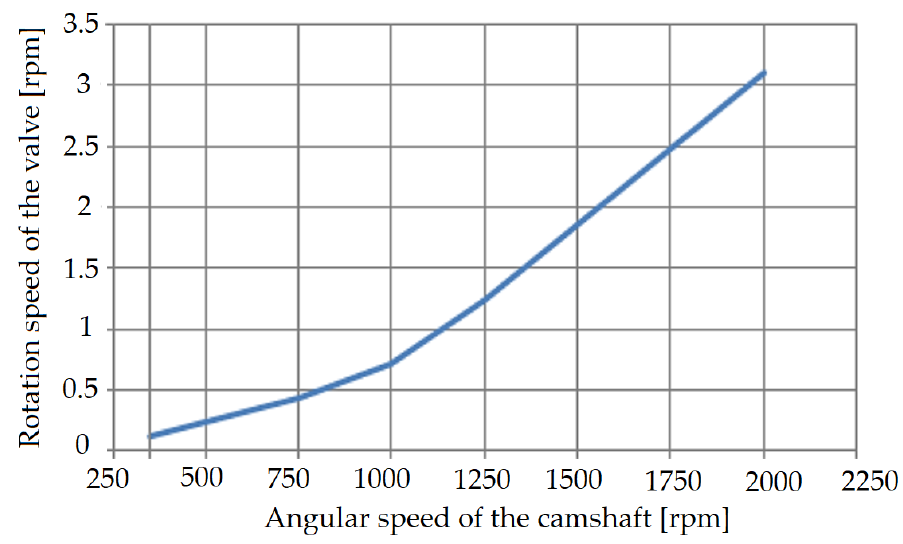
Figure 16. Influence of camshaft speed on valve rotation speed.